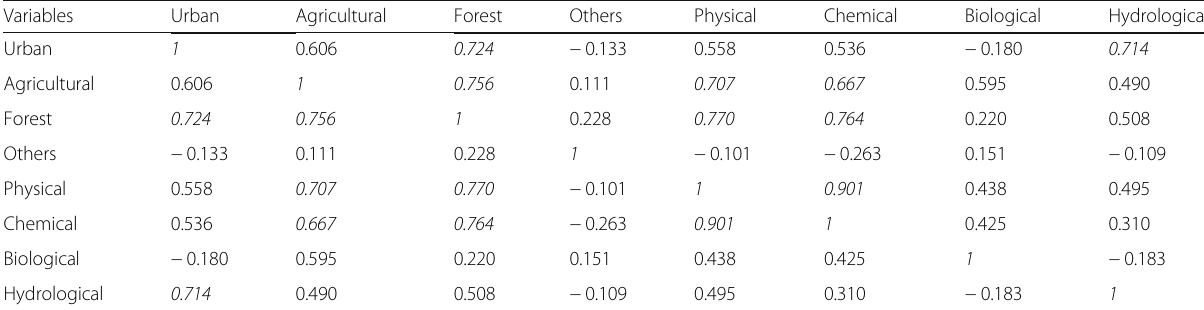
Table 4 Spearman correlation between land use and water quality indicators used in the previous studies